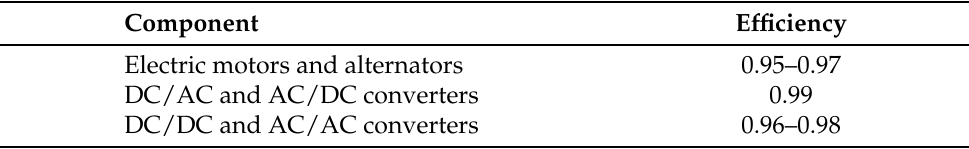
Table 4. Typical efficiencies of the electric machines and conversion